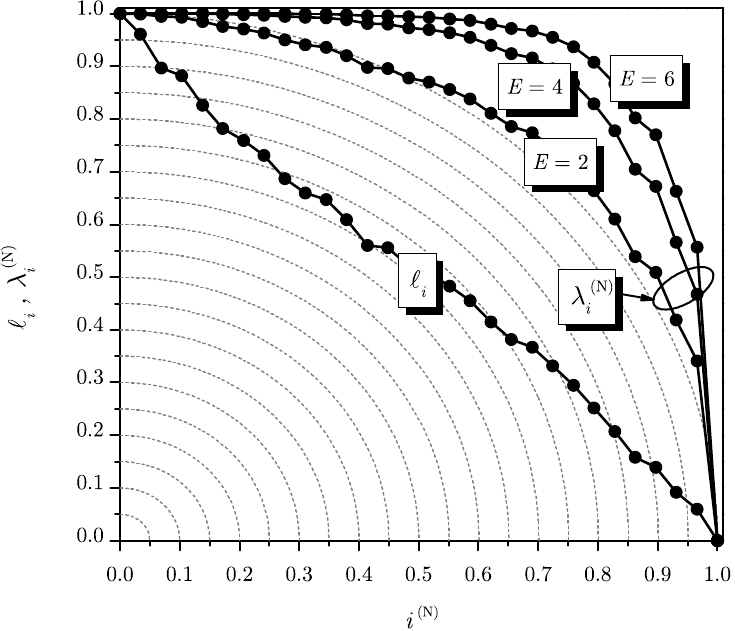
Figure 1. Graphical representation of the normalized eigenvalues and